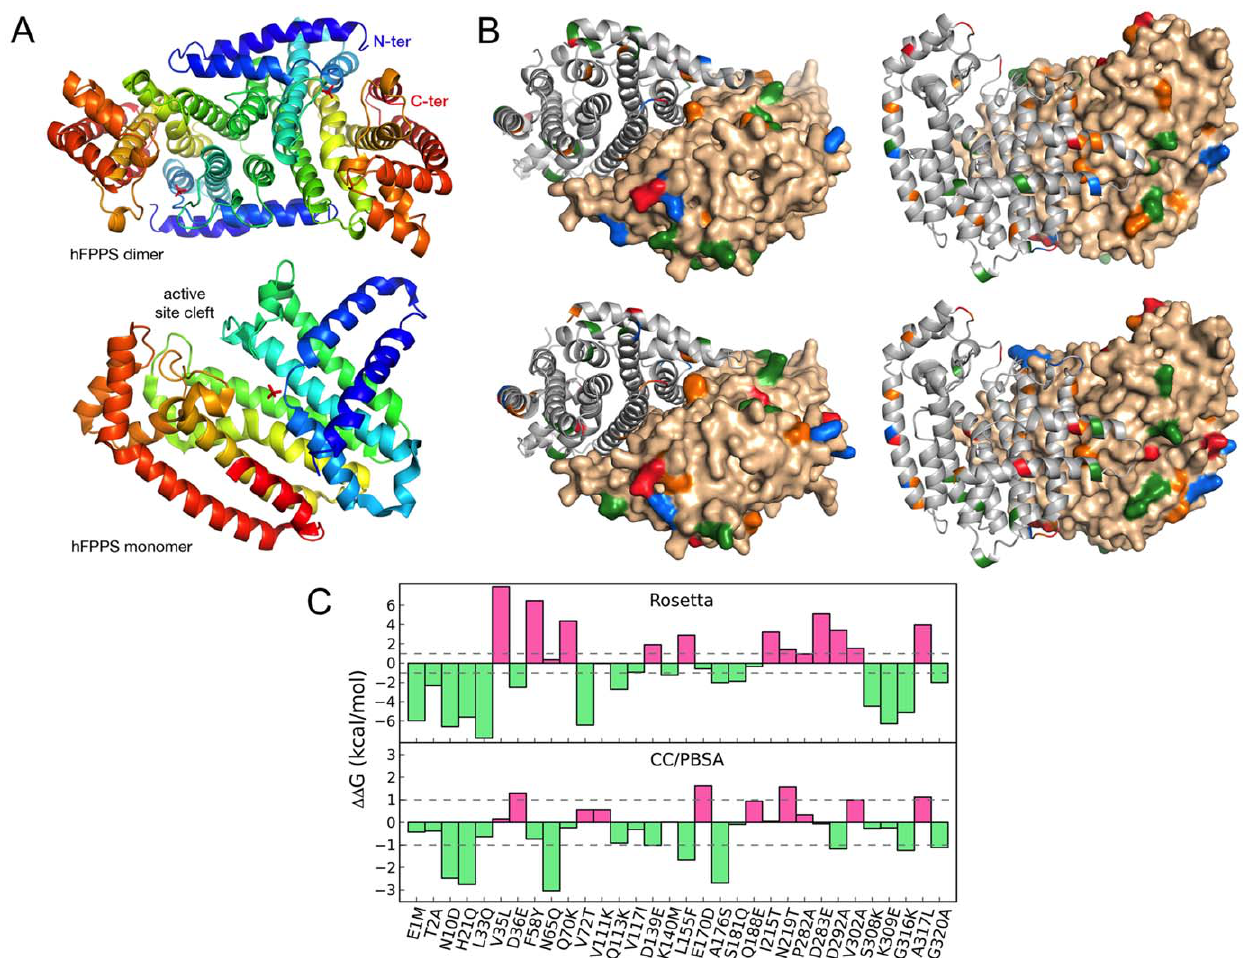
Figure 4. Homology modelling of FPS1S and FPS2 proteins and in silico DD G calculations. (A) Ribbon representation of the dimeric and monomeric structures of human FPS (PDB 2F7M), which was used to template the threading of Arabidopsis FPS1S and FPS2. The active site cleft is labelled and a bound phosphate ion is shown in sticks. (B) Sequence substitutions between FPS1S (top) and FPS2 (bottom) were mapped onto the ribbon structure (left monomer) or the molecular surface (right monomer) of the homology modeled dimers. Chemical character is colour coded as follows: red, acidic (Asp, Glu); blue, basic (Arg, Lys, His); green, polar (Ser, Thr, Asn, Gln, Tyr); orange, apolar (Met, Phe, Pro, Trp, Val, Leu, Ile, Ala). (C) Histogram of DD G (kcal/mol) upon single-site substitution calculated using Rosetta DD G application (top) or CC/PBSA (bottom). Mutations predicted to occur with a decrease in DD G are coloured green and those expected to increase DD G are coloured pink. Horizontal dashed lines at –1 to + 1 kcal/ mol bound the neutral area where DD G is supposed to contribute little to the overall stabilization or destabilization of the mutated